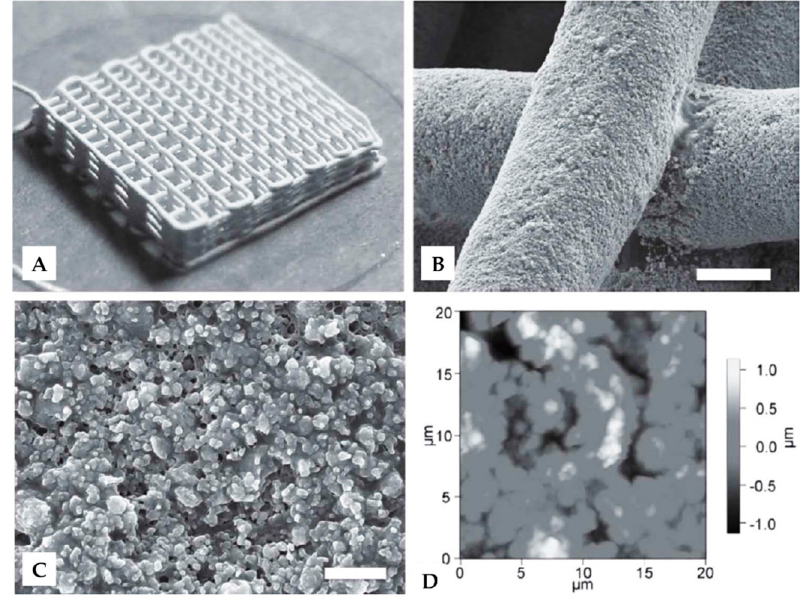
Figure 9. ( A ) Optical image of three-dimensional printing (3DP) silk/hydroxyapatite (HA) scaffold; ( B ) Scanning electron microscope image of individual silk/HA filaments at intersection. Scale bar: 100 μ m; ( C ) Higher magnification image of the silk/HA filament surface. Scale bar: 10 μ m; ( D ) Height profile of a representative silk/HA filament observed by atomic force microscopy (AFM). Reproduced from [113].